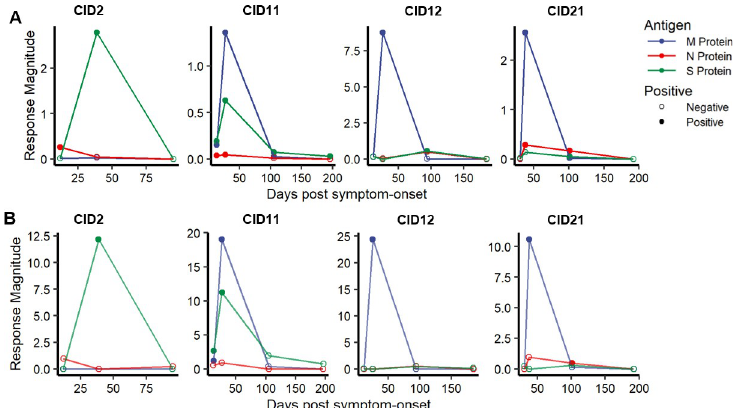
Fig 5. SARS-CoV-2-specific CD4 and cTfh responses decrease in magnitude in late convalescence. Frequency of AIM positive CD4 T cells (A) and AIM positive cTfh cells (B) over longitudinal convalescent visits for CID2, CID11, CID12, and